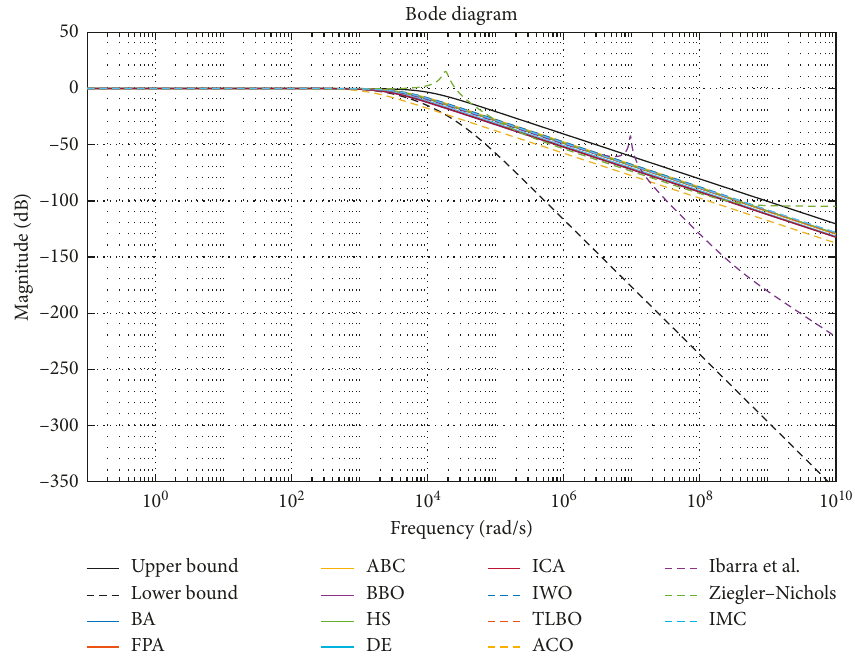
Figure 4: Compared frequency response of the closed-loop system (the nominal case).